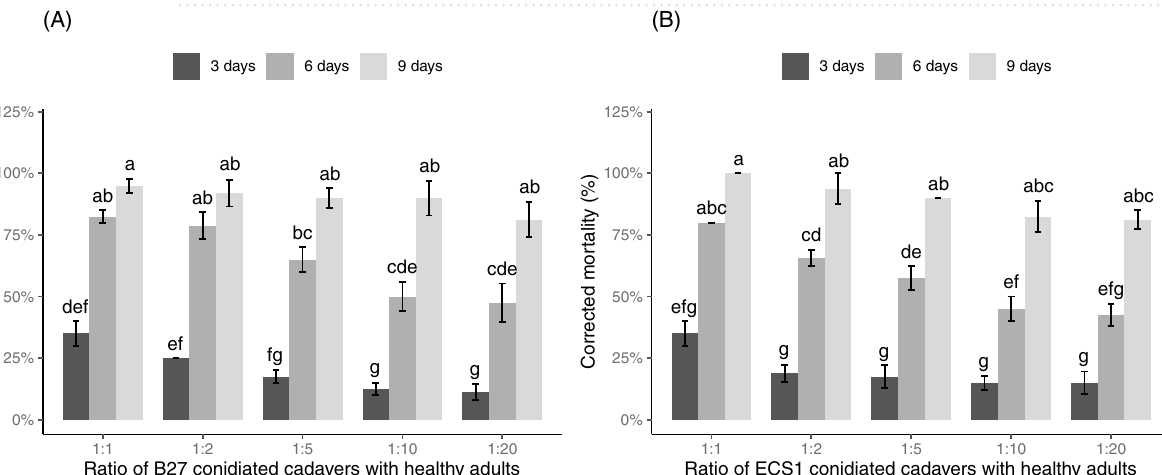
Figure 1. The mortality of healthy adult weevils at 6 days, 9 days and 12 days post-introduction of ( A ) B27 infected adults and ( B ) ECS1 infected adults at different ratios inside a 500 mL container. Results of multifactorial “F1-LD-F1” non-parametric analyses: ( A ) Wald-type statistics (WTS) = 126.13, df = 4, P < 0.001 (for ratios), WTS = 41.55, df = 2, P < 0.001 (for measured times), WTS = 42.19, df = 8, P < 0.001 (for interactions), ( B ) WTS = 34.48, df = 4, P < 0.001 (for ratios), WTS = 62.59, df = 2, P < 0.001 (for measured times), WTS = 8.31, df = 8, P = 0.4 (for interactions). Columns with different letters are significantly different from each other (pairwise Wilcoxon rank-sum test, P < 0.05). ( A , B ) were analysed separately. Error bars represent standard errors.